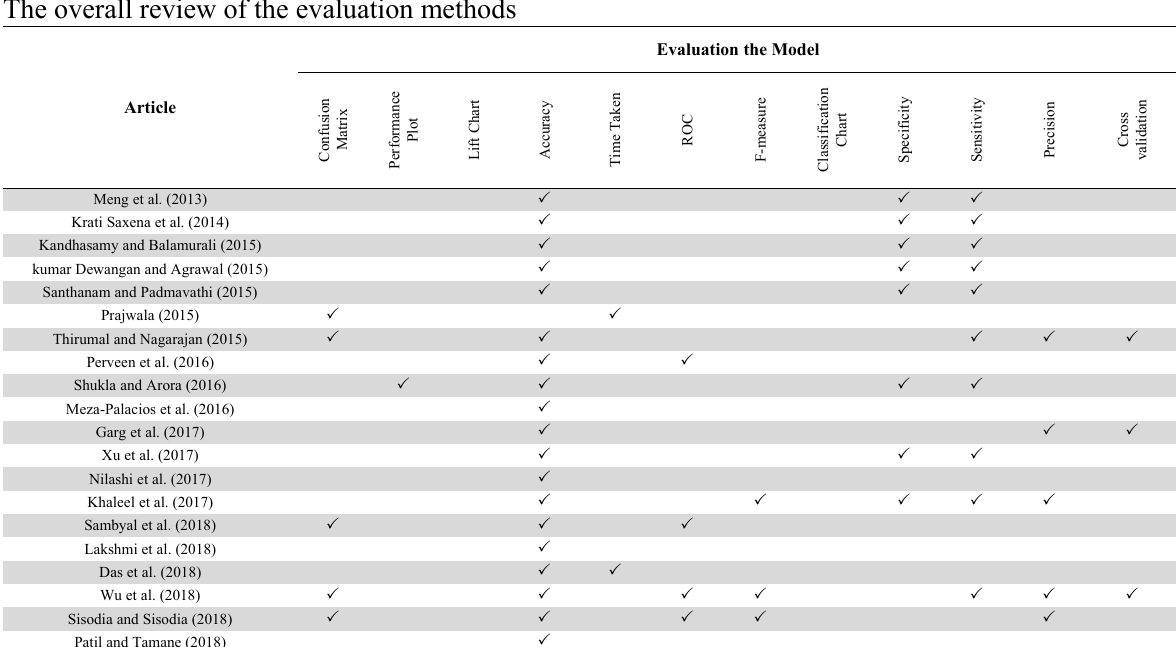
The overall review of the evaluation methods